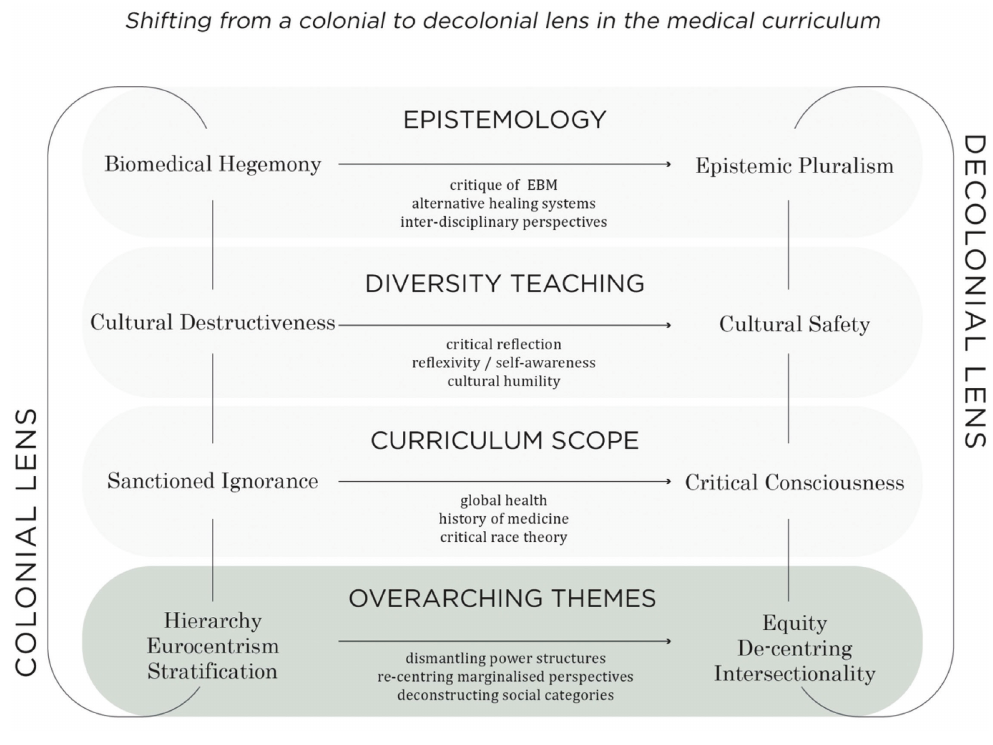
Figure 2: A decolonizing framework for the medical curriculum scaffolded by epistemic pluralism, cultural safety and critical consciousness, with a summary of overarching themes (Source: Authors,